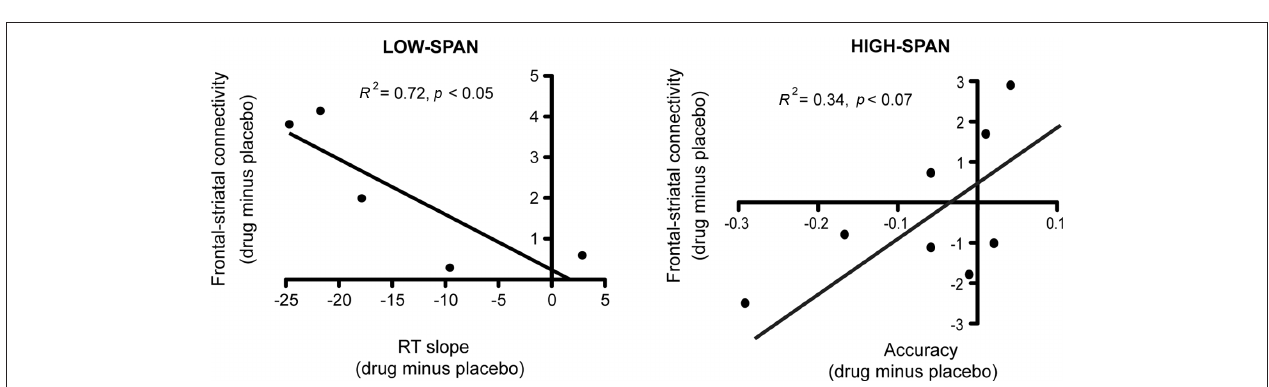
2 | The effect of bromocriptine on fronto-striatal connectivity during performance of a delayed recognition memory task is dependent on working memory span. The mean correlation coefficient (expressed as a z -score) between